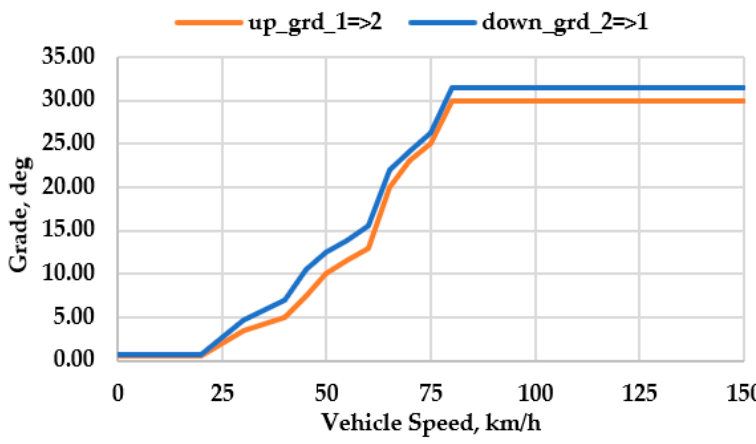
Figure 6. Gearshift schedule map based on the road grade.